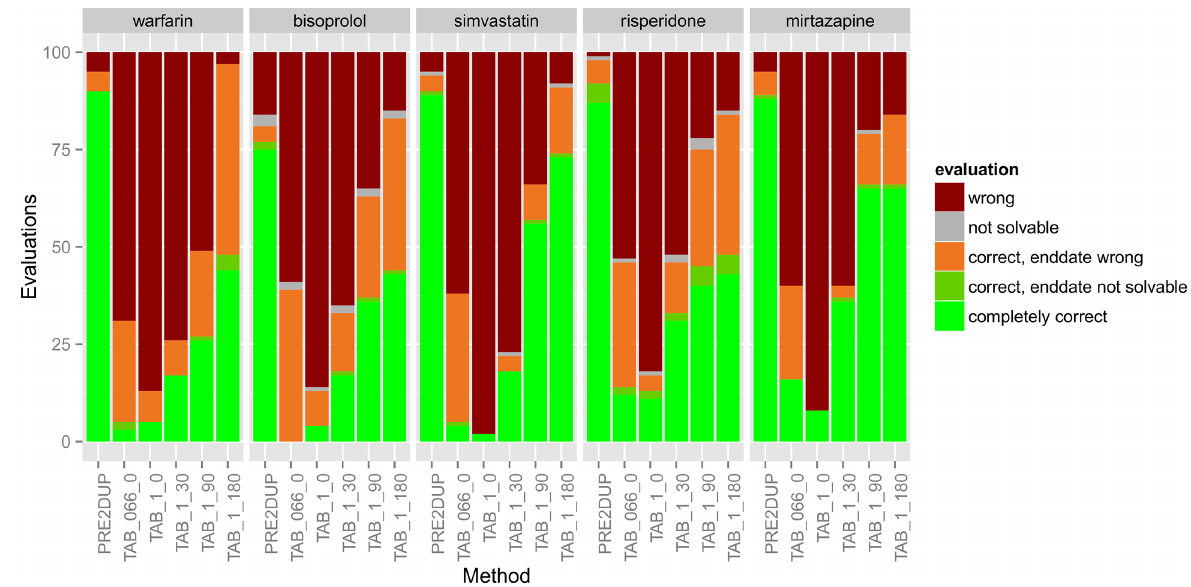
Fig 2. Evaluation results of 100 drug use periods produced by tablet methods along with PRE2DUP for five drugs. Abbreviations explainedin text.